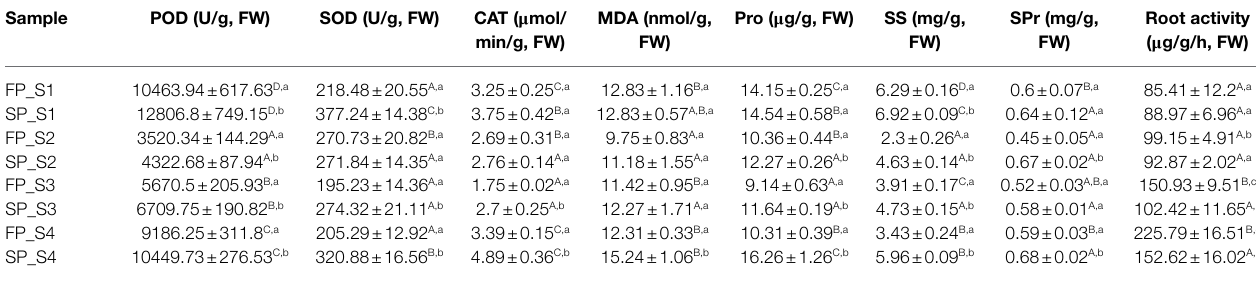
TABLE 1 | Physiological responses of patchouli roots under continuous cropping stress.